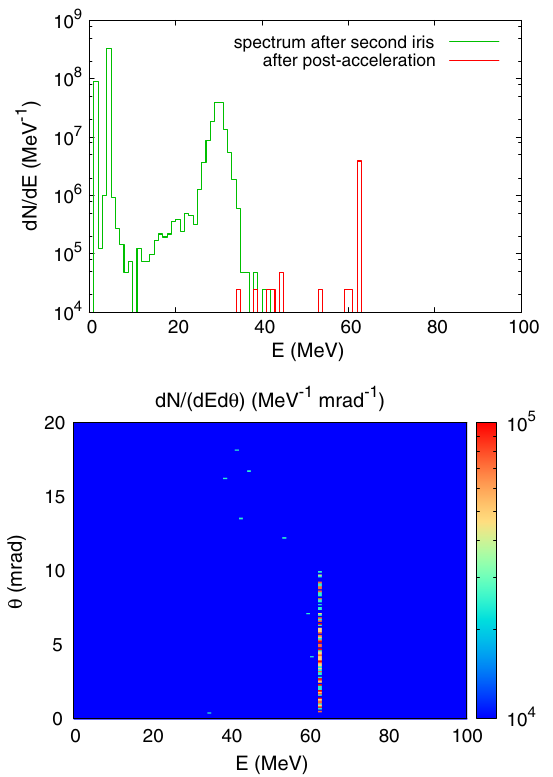
FIG. 11. Upper frame: Plot in a logarithmic scale of the proton energy spectrum after postacceleration by five modules of ACLIP (red curve) for the target with quasicritical density (MVA) compared with the spectrum after the second collimator (dark green curve). Lower frame: Plot of the energy-angle distribution after postacceleration in a logarithmic color